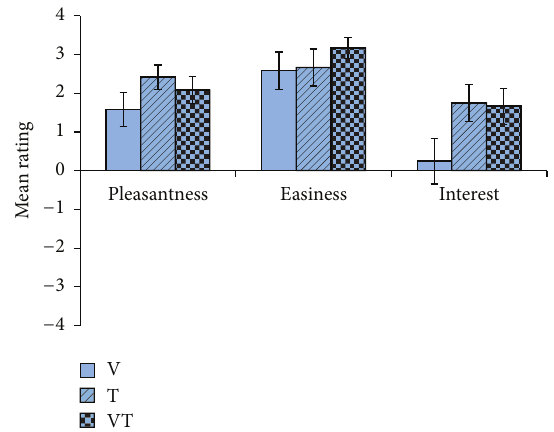
Figure 4: Mean ratings for pleasantness, easiness, and interest of the knee lift tasks in visual (V), tactile (T), and visual-tactile (VT) modality conditions. Error bars represent